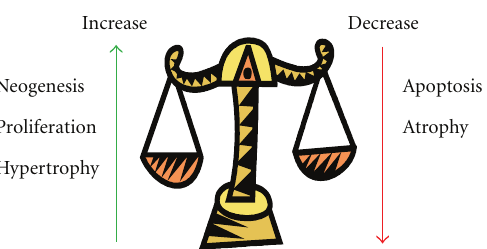
Figure 1: Beta-cell mass equilibrium. Beta-cell proliferation, neogenesis, and hypertrophy (enlarged cell size) increase beta-cell mass, while apoptosis and atrophy (reduced cell size) decrease beta- cell